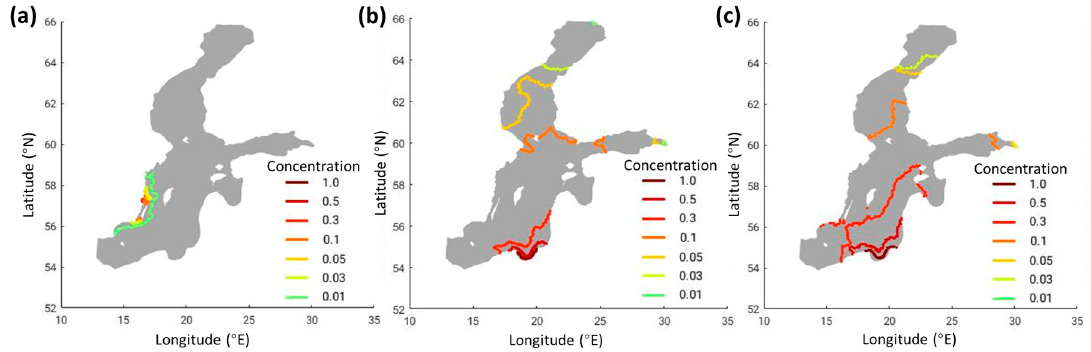
Figure 8. Isolines of maximum solute concentration over the simulation period for the total nutrient release scenario. ( a ) Kalmar County coast case with standard solute release; ( b ) Vistula River coast case with total nitrogen (TN)-proportional 35.6 times higher solute release; ( c ) Vistula River coast case with total phosphorus (TP)-proportional 55.1 times higher solute release.